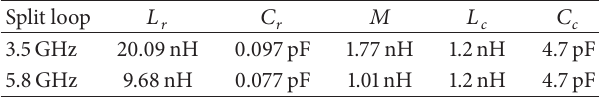
Table 3: Calculated result of elements for the equivalent circuit in Figure